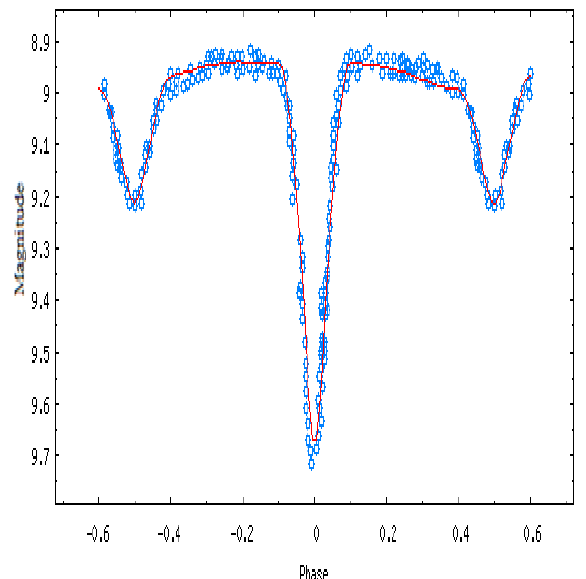
Fig.5: The best match between the synthetic and the experimental light curves of binary RT